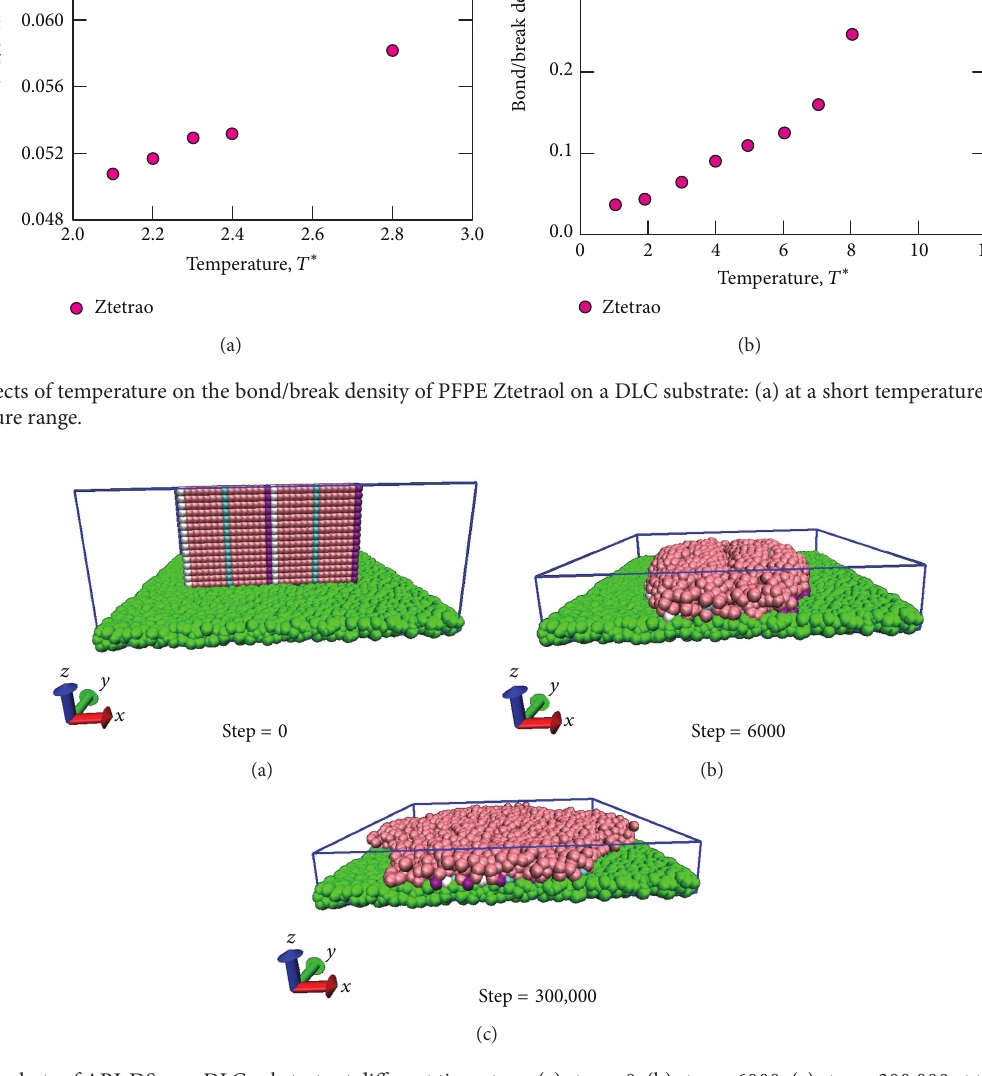
Figure 13: Snapshots of ARJ-DS on a DLC substrate at different time steps: (a) step = 0; (b) step = 6000; (c) step = 300,000 at temperature 𝑇 ∗ = 4 (668 K = 395 ∘ C) with